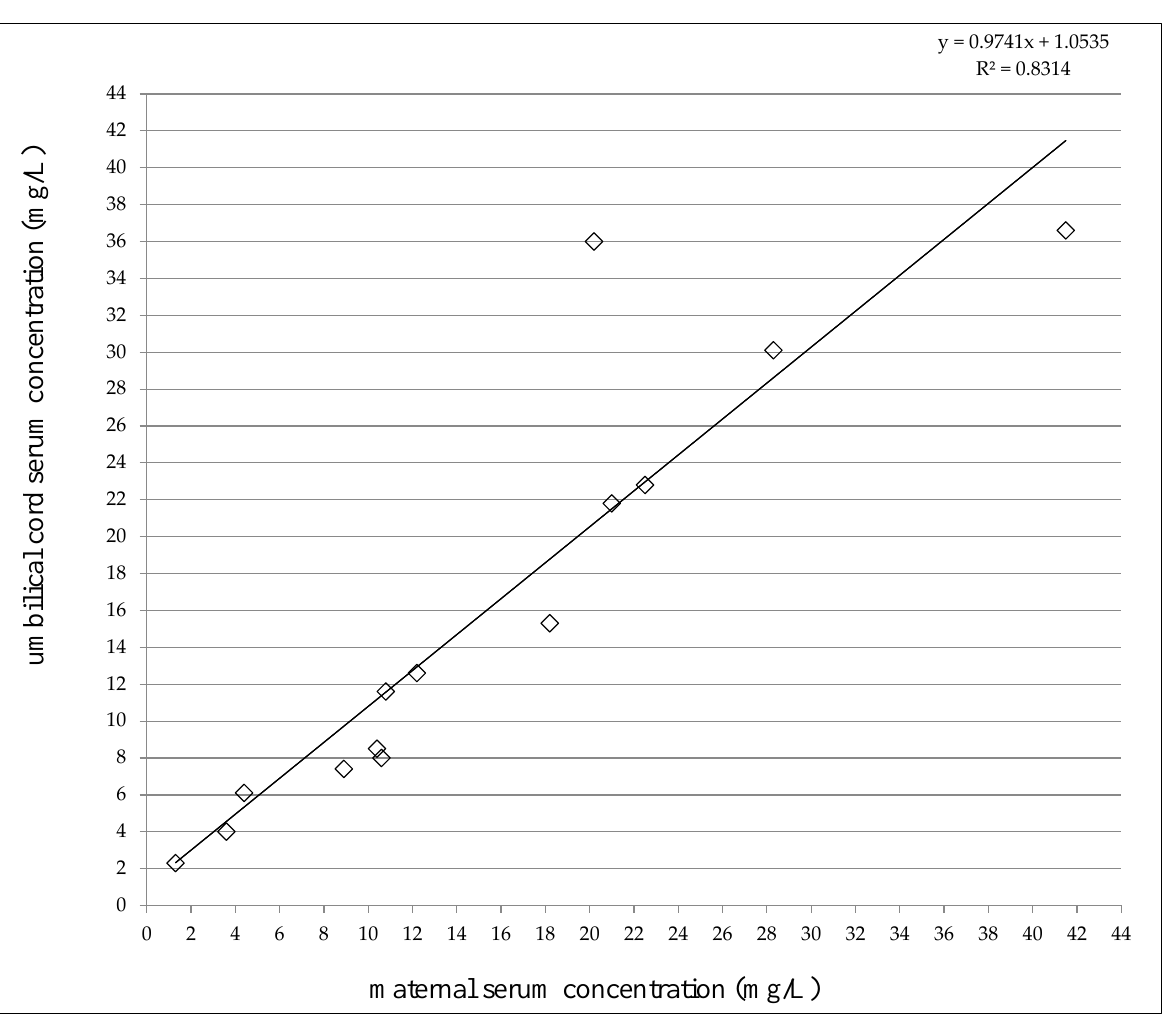
Figure 1. Correlation between umbilical cord serum and maternal serum concentrations of levetiracetam. Number = 14, p < 0.0001, the Pearson correlation coefficient = 0.9118. Table 2. Dosage, apparent oral clearance (Cl), maternal (M), and umbilical cord (UC) serum concentrations of levetiracetam and its ratio at delivery.